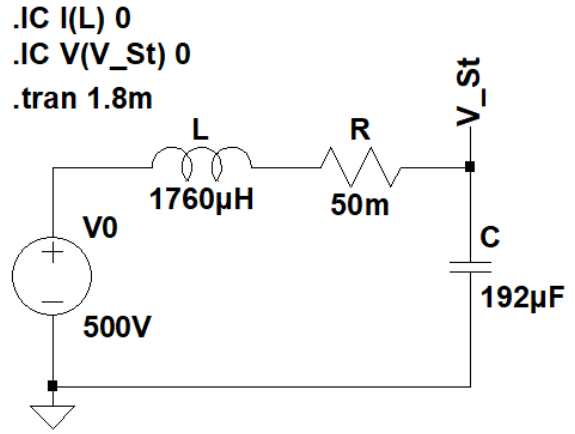
Figure 2. Simplified circuit for basic studies on resonant charging.